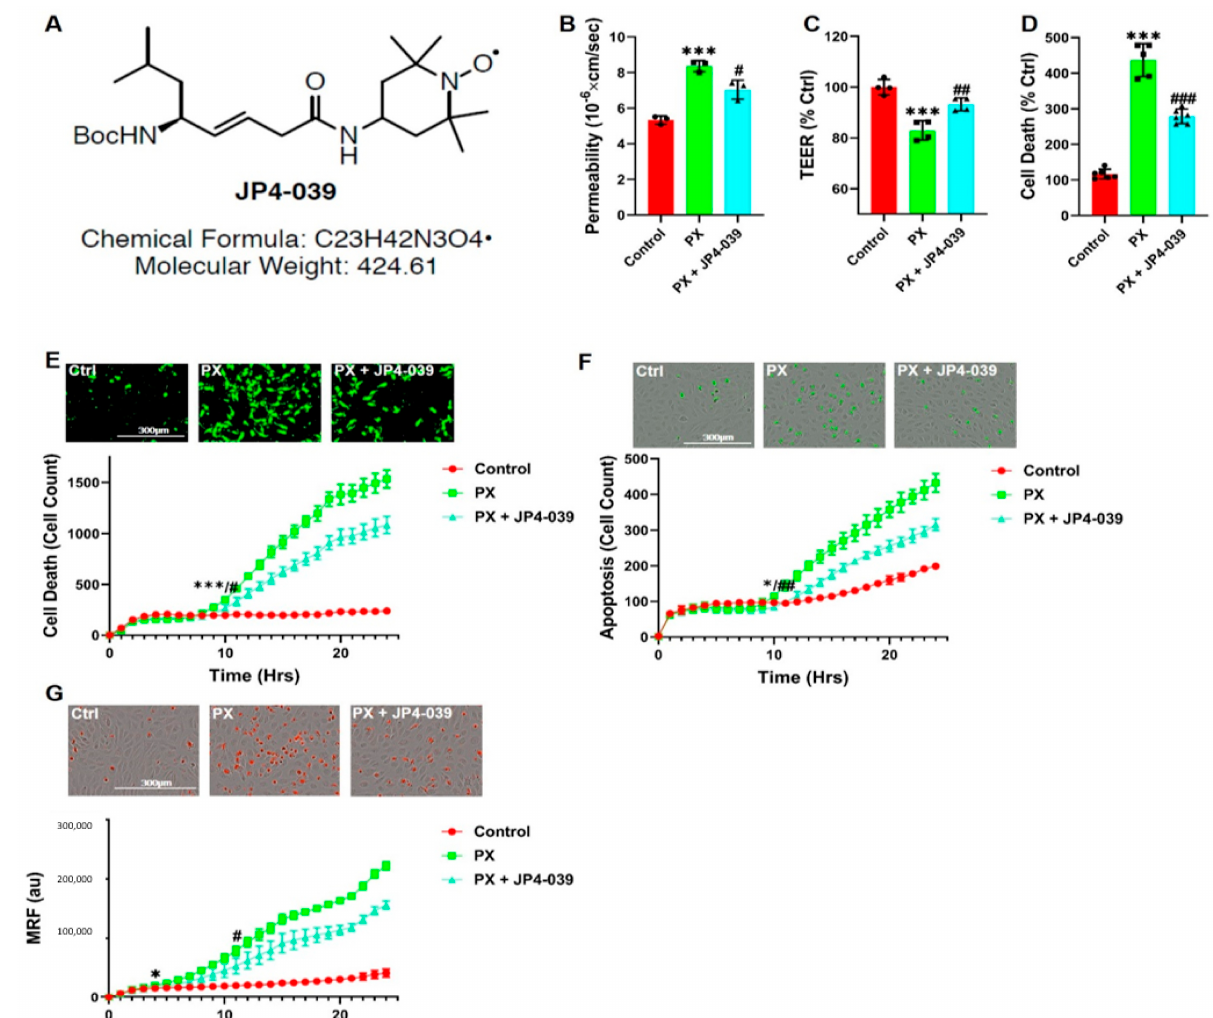
Figure 5. JP4-039 rescues PX-induced toxicity and permeability increase in the BBB injury model; ( A ) A chemical formula diagram of JP4-039; ( B ) Permeability of sodium fluorescein (NaF) was measured across the BBB in vitro model (from